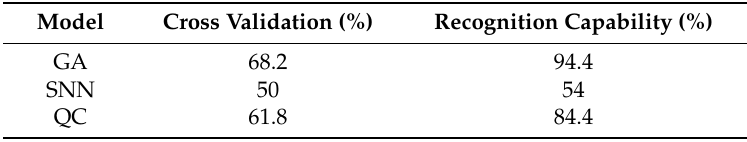
Table 1. Three different algorithms: genetic algorithm (GA), supervised neural network (SNN), and quick classifier (QC) were used to distinguish between the peptide composition of the group of women diagnosed with GTN before the treatment and the pregnant control group.